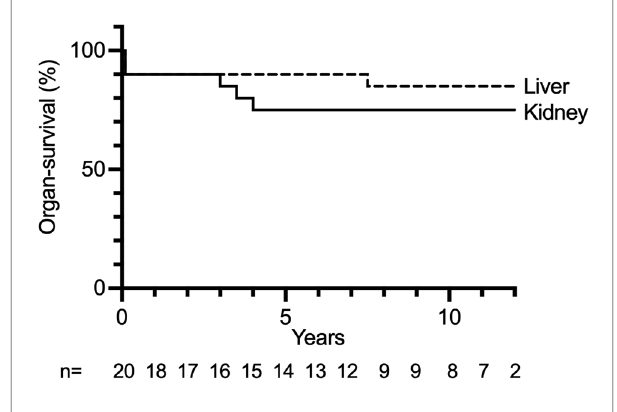
FIGURE 1 Liver and kidney graft survival after each CLKT performed. n : number of CLKTs under follow-up, censored at 12